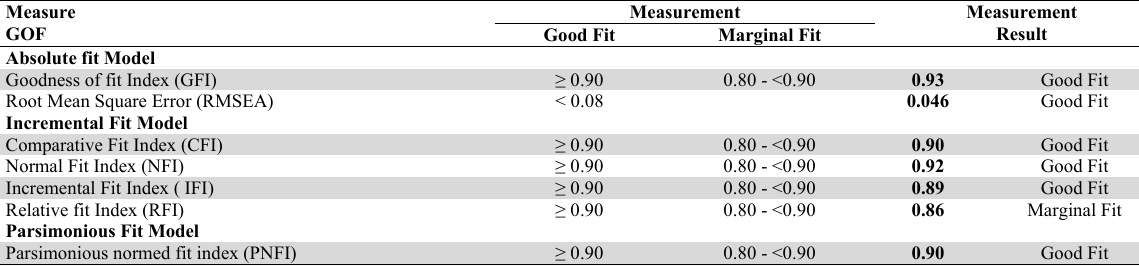
Goodness of fit (GOF)